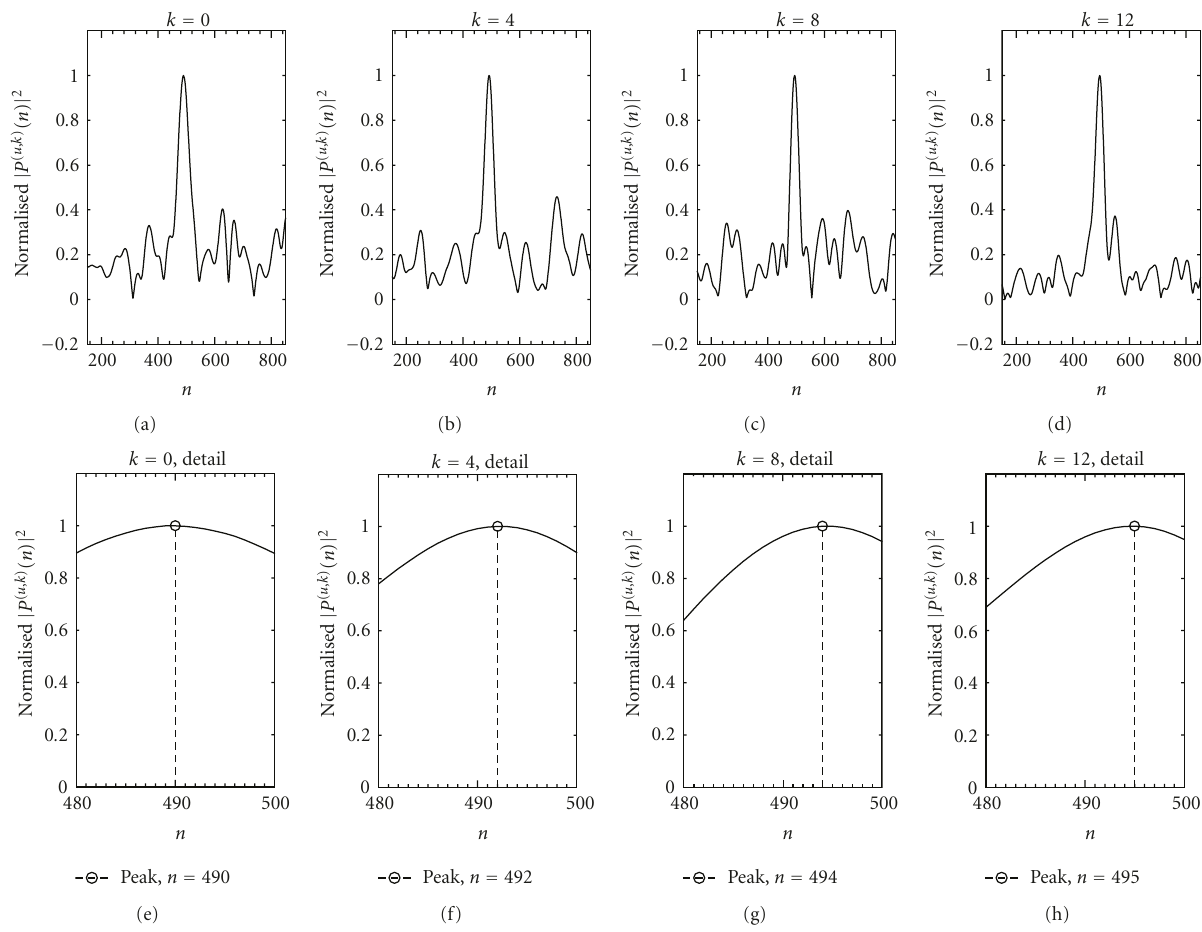
Figure 3: Example of normalized metric (18) for 4 subchannels of a given user to highlight the variation of the peak